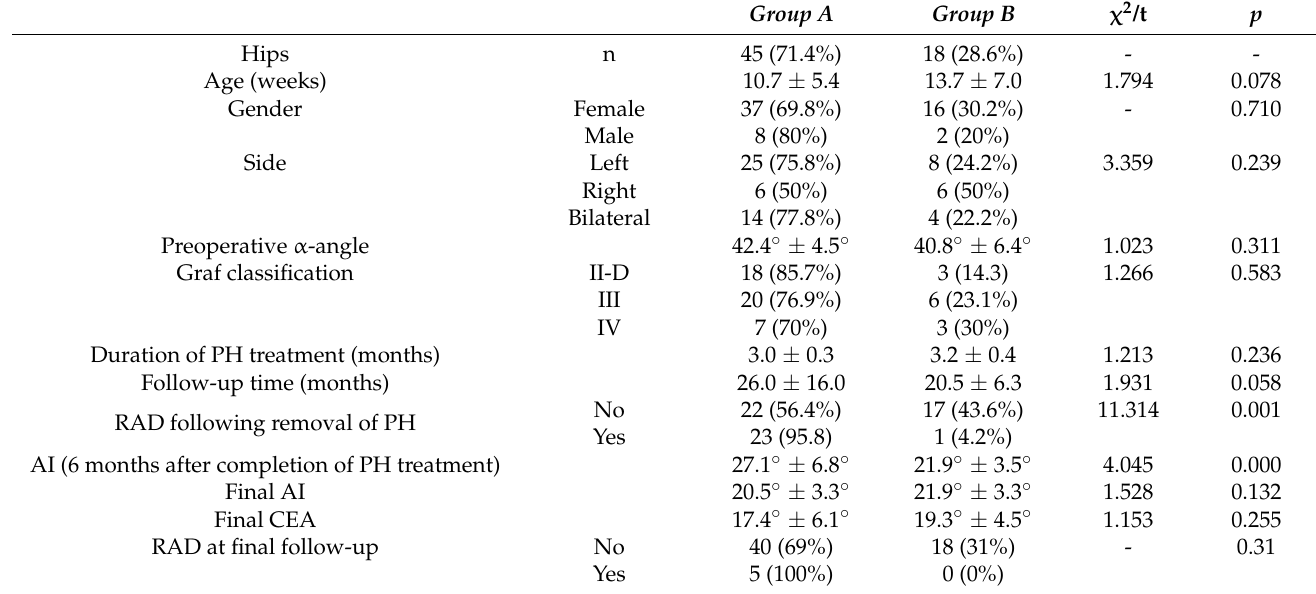
Table 1. Comparison of clinical data between patients achieving normal hips on hip US ( Group A ) and pelvis radiographs ( Group B ) at the end of PH treatment.